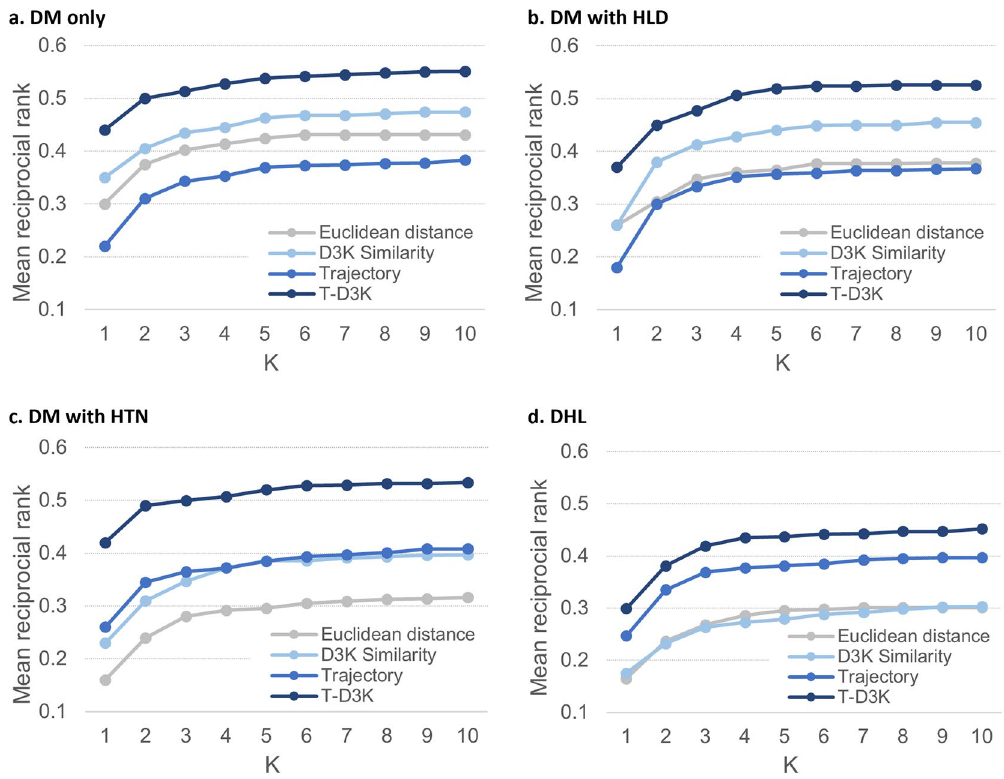
Figure 4. Mean reciprocal rank (MRR) for four groups of